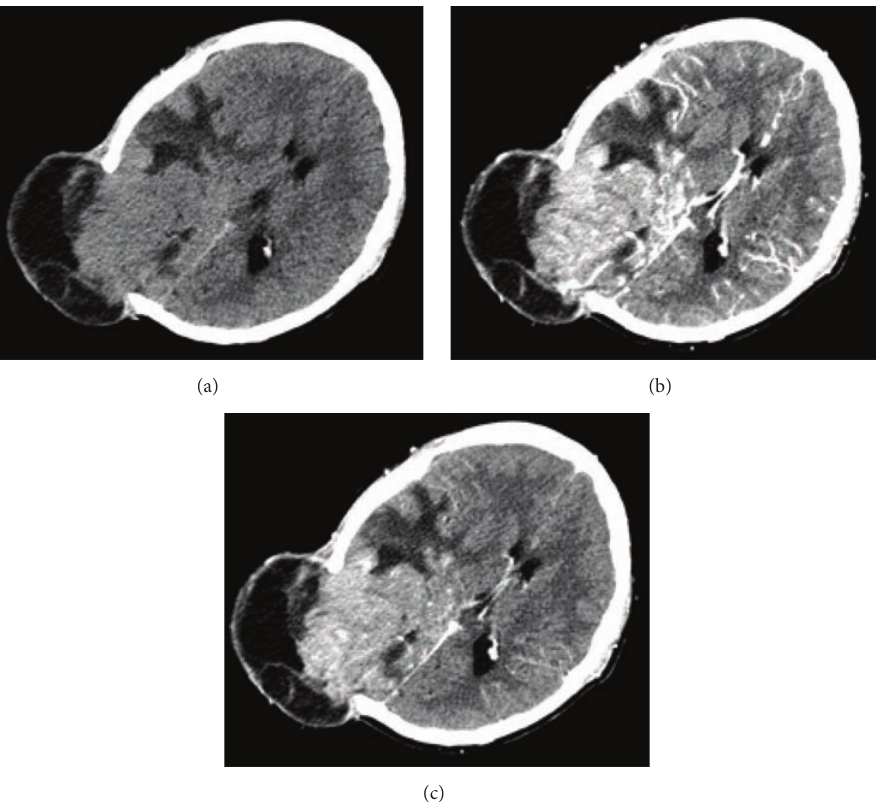
Figure 4: Follow-up CT images showed recurrent tumor herniating through the craniectomy defect. An axial CT image showed an irregular isodense mass with prominent perilesional vasogenic edema located in the right parietal-occipital-temporal lobe (a). Contrast-enhancement CT images showed intense homogeneous enhancement (b,